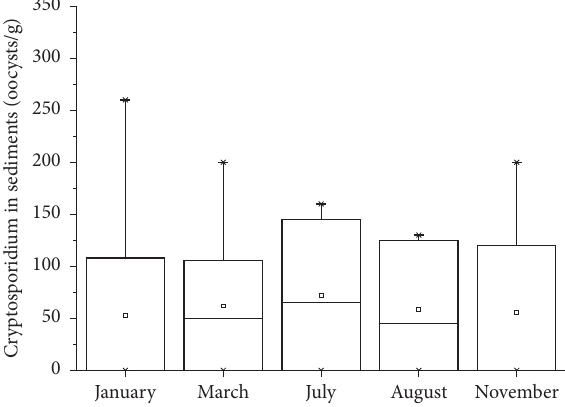
Figure 3: Cryptosporidium oocysts in sediment samples.